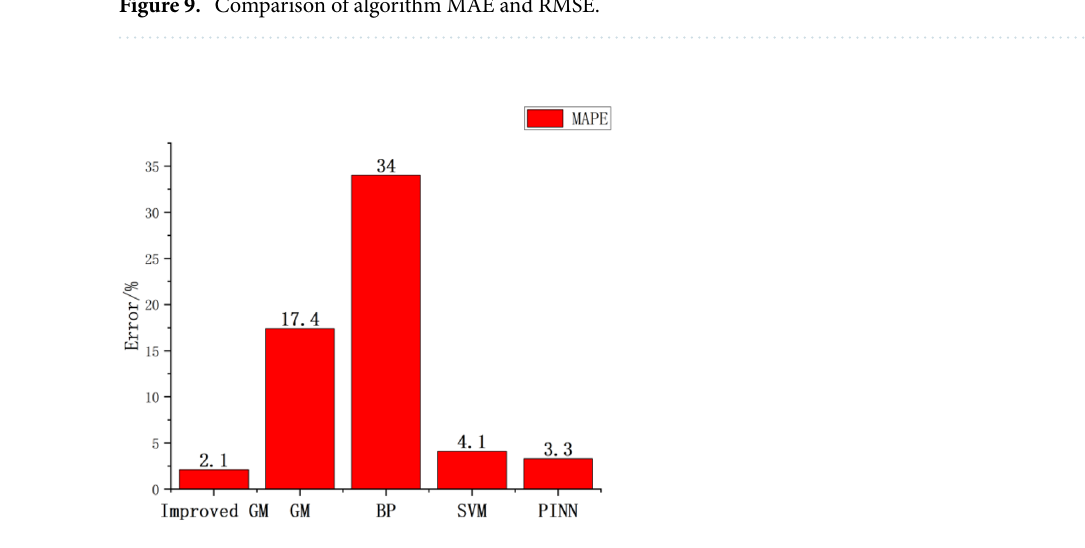
Figure 10. Comparison of algorithm MAE and RMSE.